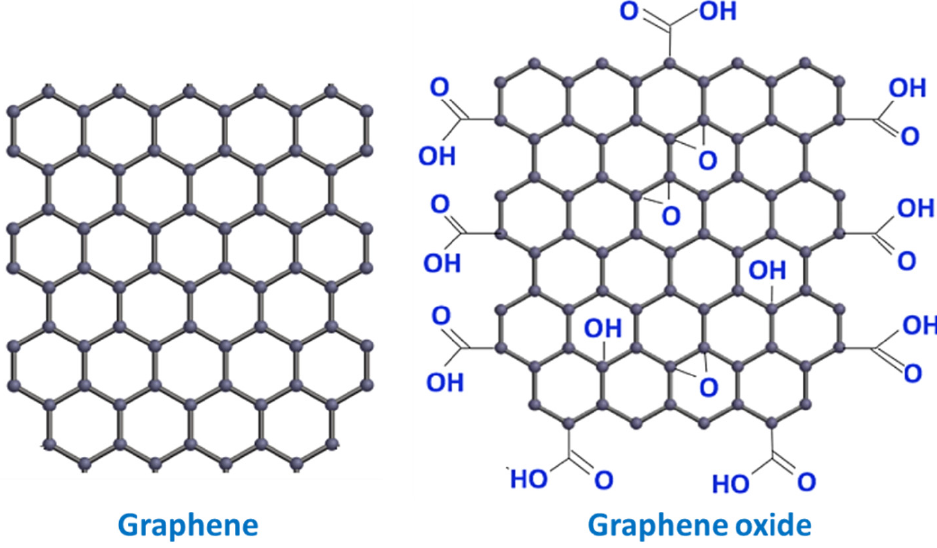
Figure 1. Graphene and graphene